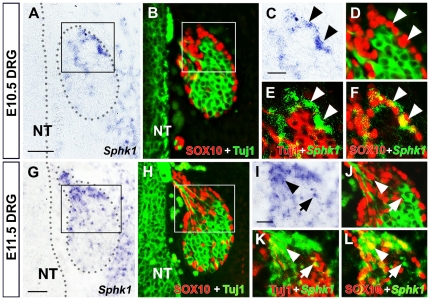

Sphk1 expression in the developing dorsal root ganglion.
Sphk1 transcript was detected by section in situ hybridization followed by Tuj1 and SOX10 immunostaining. (A–F) Sphk1 expression in E10.5 (32–35 somites) dorsal root ganglion. (A) Sphk1 in situ signal (purple) can be detected in some cells in the dorsal root ganglion at this stage (DRG outlined by grey dots). (B) The same section in A processed for Tuj-1 (red) and SOX10 (green) immunofluorescence. Most of the SOX10+ neural crest progenitor cells are found at the periphery and cap region of the ganglion while Tuj1+ neurons are more centrally located. (C–F) Enlarged image of boxed area in A and B. (C,D) Sphk1 transcript is primarily located in the periphery of the DRG and co-incides with the occurrence of SOX10+ cells (arrowhead). (E,F) In these panels, Sphk1 in situ signal is pseudo-colored green, Tuj-1 (red, E) and SOX10 (red, F) to visualize co-localization. Sphk1 mRNA is associated with SOX10+ cells (arrowheads); Tuj1+ neurons do not express Sphk1 at this time. (G–L) Sphk1 expression in E11.5 (40–42 somites) dorsal root ganglion. (G) Sphk1 signal (purple) is seen mostly in the cap region of the ganglion (DRG outlined by grey dots). (H) Same section in G immunostained with Tuj1 (green) and SOX10 (red). Majority of the SOX10+ cells (red) are located in the periphery and cap region of the DRG but several SOX10+ cells can also be found in the central region. (I–L) Enlarged image of boxed area in G and H. (I,J) Similar to E10.5, many SOX10+ cells express Sphk1
(arrowhead) but some neurons (arrow) also express Sphk1 at E11.5. (K,L) Sphk1 signal is pseudo-colored green and Tuj1 red (K), SOX10 red (L) to confirm co-localization of signals. Sphk1 mRNA is found in SOX10+ cells (arrowhead), cells that are Sphk1+/SOX10+ appear yellow in L. Some neurons express Sphk1 at this time (arrow). NT = neural tube. Scalebar for A, B and G, H = 50 µm; scalebar for C–F and I–L = 20 µm.